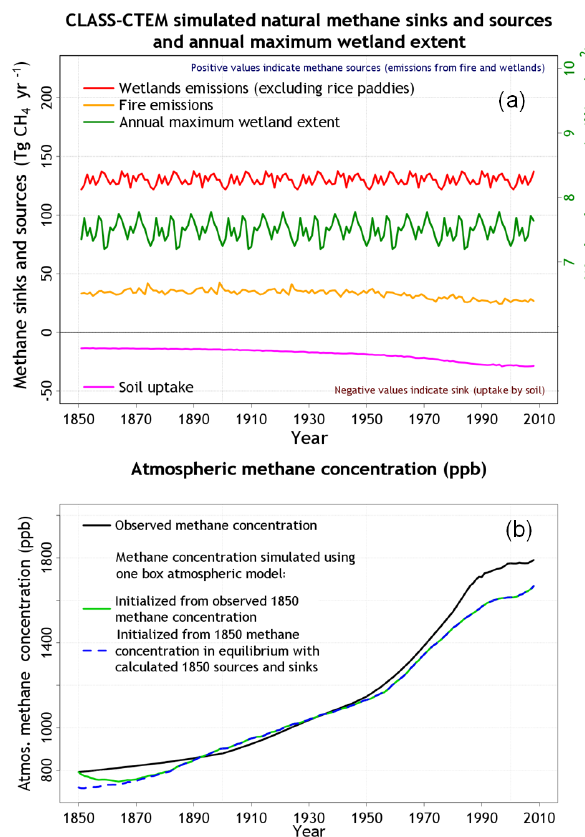
Figure 5. Time evolution of simulated natural methane fluxes (shown on the primary y axis) and annual maximum wetland extent (shown on the secondary y axis) by CLASS-CTEM for the 1851– 2008 period for the case when wetland extent and methane emis- sions are not allowed to respond to changing climate and increase atmospheric CO 2 over the historical period ( a ). Panel (b) shows the simulated methane concentration over the historical period, together with its observation-based values, when the natural fluxes shown in panel (a) are used within the framework of the one-box model of atmospheric methane.